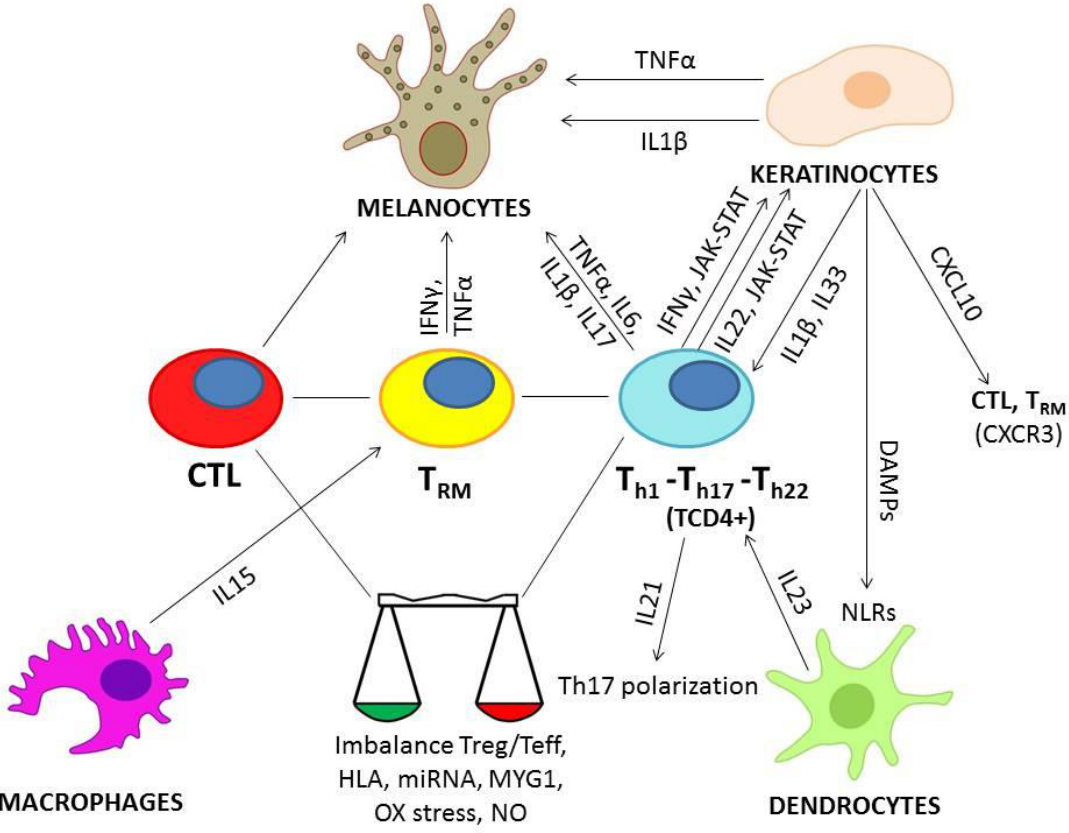
Figure 1. Role of the main cellular populations and interleukins involved in the pathogenesis of vitiligo. Arrows are matched with related pathways/interleukins primarily involved in the interactions between cells.